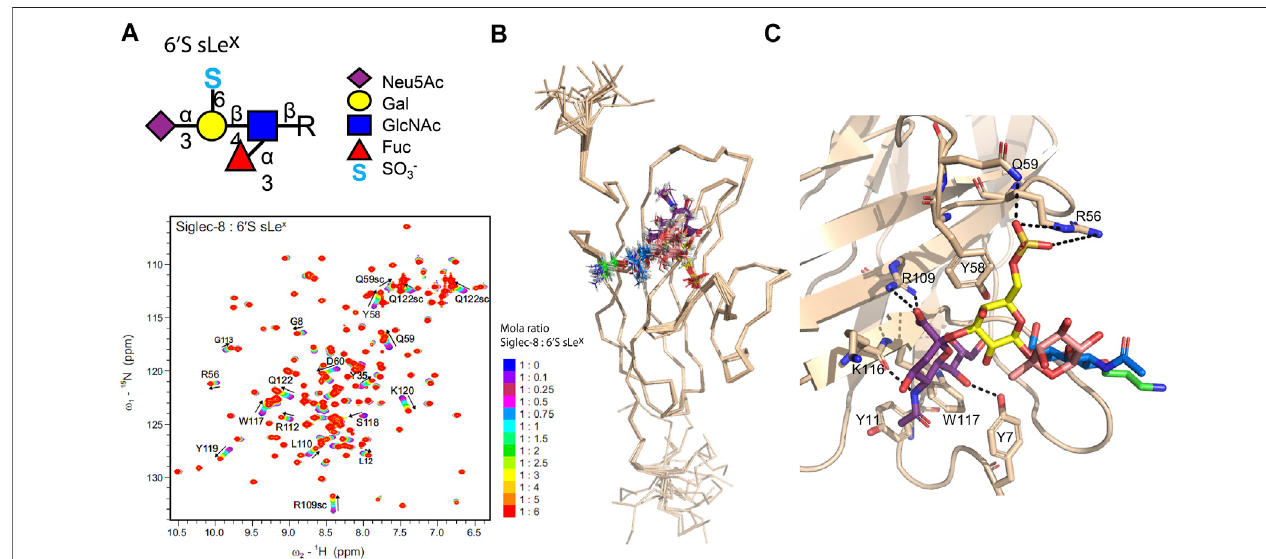
FIGURE 3 | Human siglec-8/6 ′ S sLe x complex deduced by the NMR and molecular modeling. (A) . 1 H, 15 N-HSQC based titration of siglec-8 with increasing amounts of 6 ′ S sLe x . The successive 1 H, 15 N spectra of siglec-8 collected after the gradual addition of 6 ′ S sLe x are superimposed. The spectrum of siglec-8 in the absence of6 ′ S sLex is displayed in dark blue, and the spectrum of siglec-8 in the presence of6 equivalents of 6 ′ SsLe x isdisplayed in red. The most perturbed residues are identi fi ed, and the directions of the peak ’ s shifts are indicated with arrows. (B) . An ensemble of the 20 structures with the lowest energy of siglec-8 complexed with6 ′ SsLe x determinedbyNMR. (C) .Representationofthesiglec-8/6 ′ SsLe x interface,wherethe6 ′ SsLe x andtheinteractingaminoacidsaredisplayed assticksand the hydrogen bonds between Neu5Ac/Gal 6 ′ -sulfated and siglec-8 are illustrated as dashed lines. Adapted from Pröpster et al. (2016).